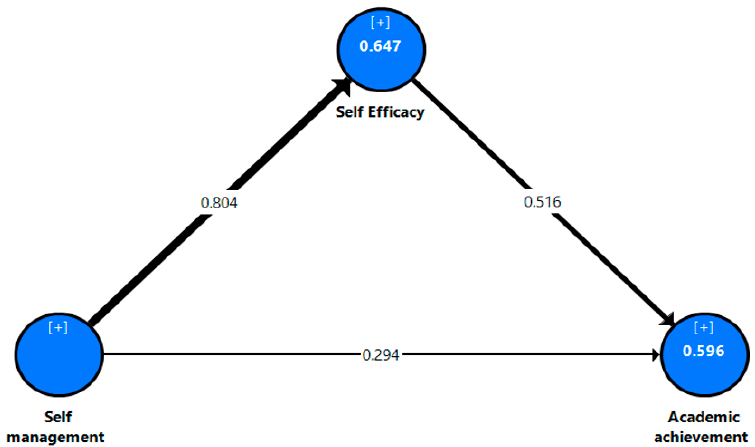
Figure 2. Results of the structural model with data from all students.